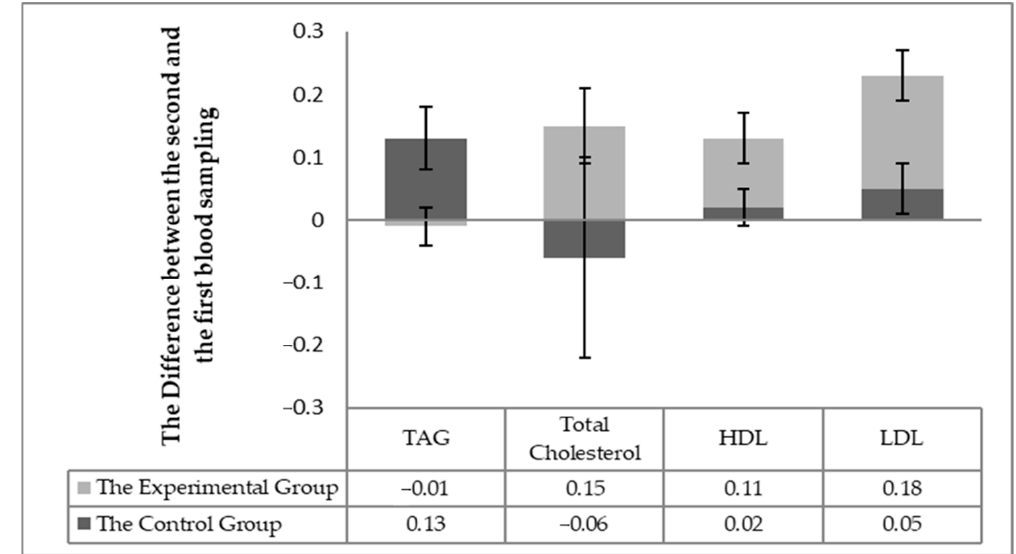
Figure 2. The difference between the monitored parameters (TAG, the total cholesterol, LDL, and HDL cholesterol) between the first and second sampling in individual horses.